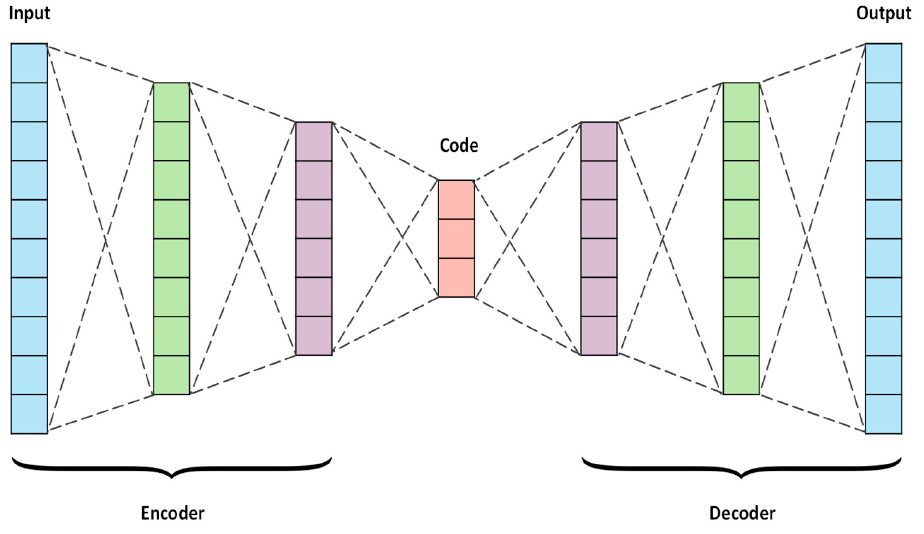
Figure 3. A representation of an autoencoder [46].